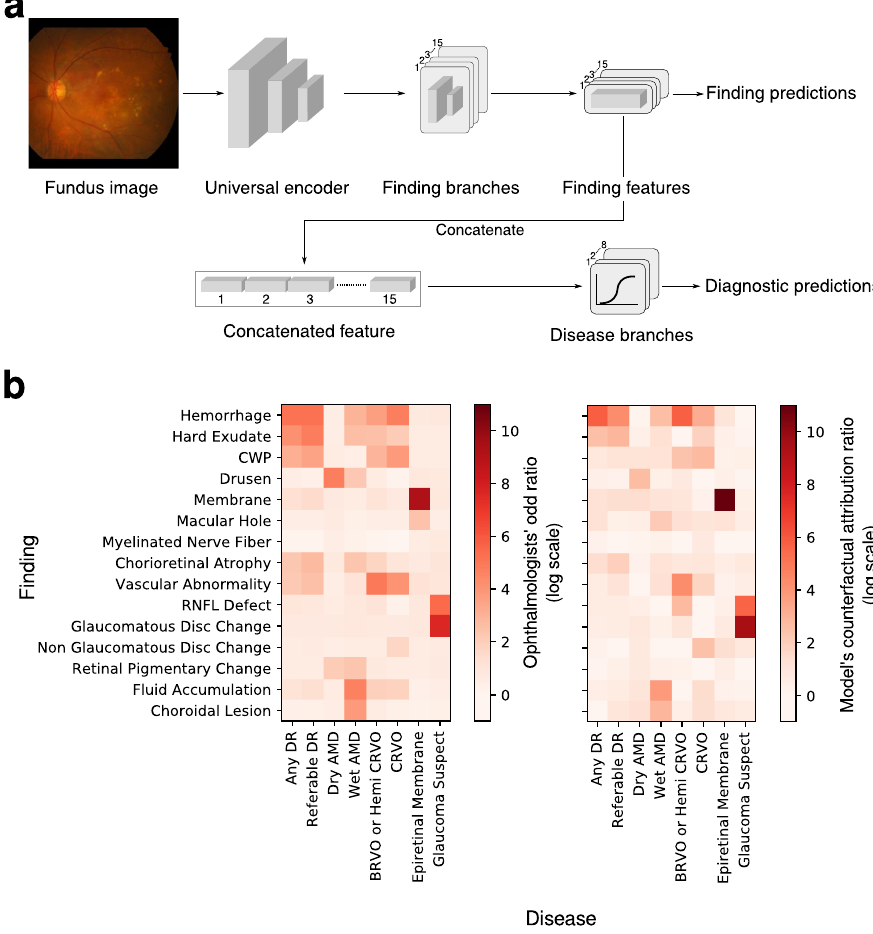
Figure 1. ( a ) Overall architecture of the deep learning-based model. ( b ) Relationships between ophthalmolgic findings and eye diseases computed by aggregate annotations of human experts and the model’s counterfactual attribution